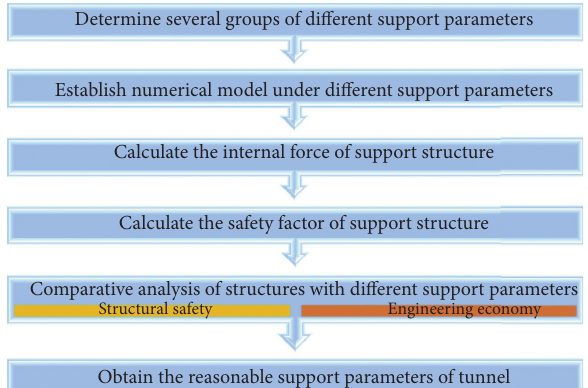
Figure 19: Calculation process for reasonable support parameters. Table 5: Physical and mechanical parameters of surrounding rock.